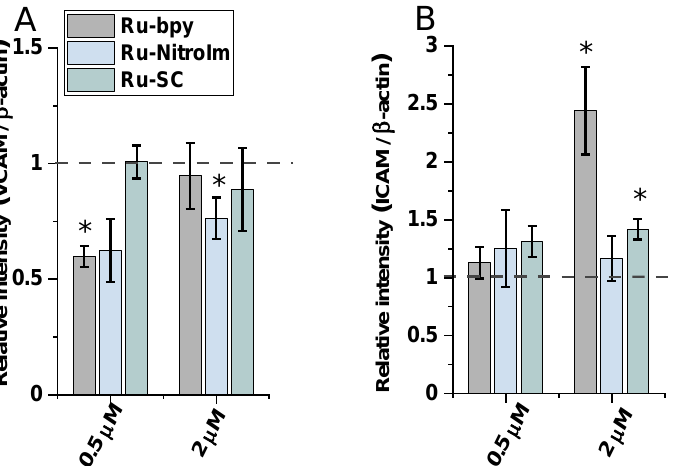
Figure 6. The expression levels of ( A ) VCAM-1 and ( B ) ICAM-1 measured by western blot in HMEC-1 protein extracts obtained after 24 h of treatment with [Ru(dip) 2 (bpy)]Cl 2 (gray), [Ru(dip) 2 (bpy-nitro)]Cl 2 (blue) and Ru(dip) 2 (bpy-SC)]Cl 2 (green) (0.5 or 2 µM). TNF- α (0.1 ng/mL) was used as a positive inducer control. Expression for VCAM-1 and ICAM- 1 were calculated with respect to β -actin. * p < 0.05.